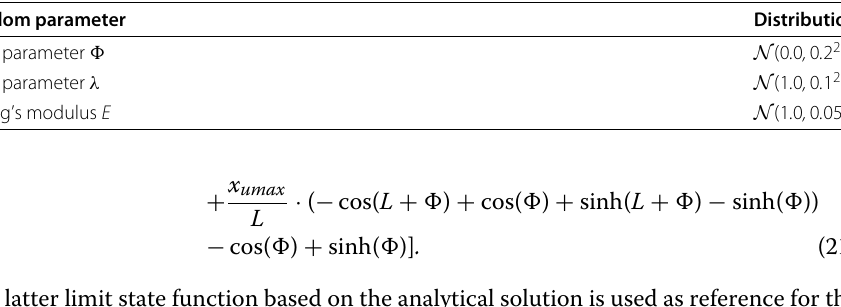
Table1 Distributions of random parameters in example 1D truss